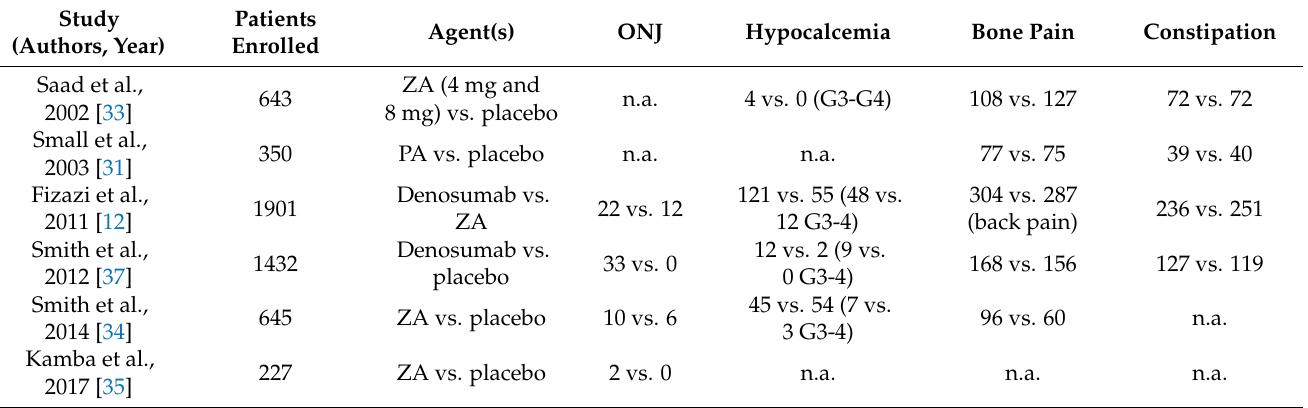
Table 2. Adverse events of Bone Targeting Agents in Prostate Cancer. ZA = zoledronic acid, PA = pamidronic acid, ONJ = osteonecrosis of the